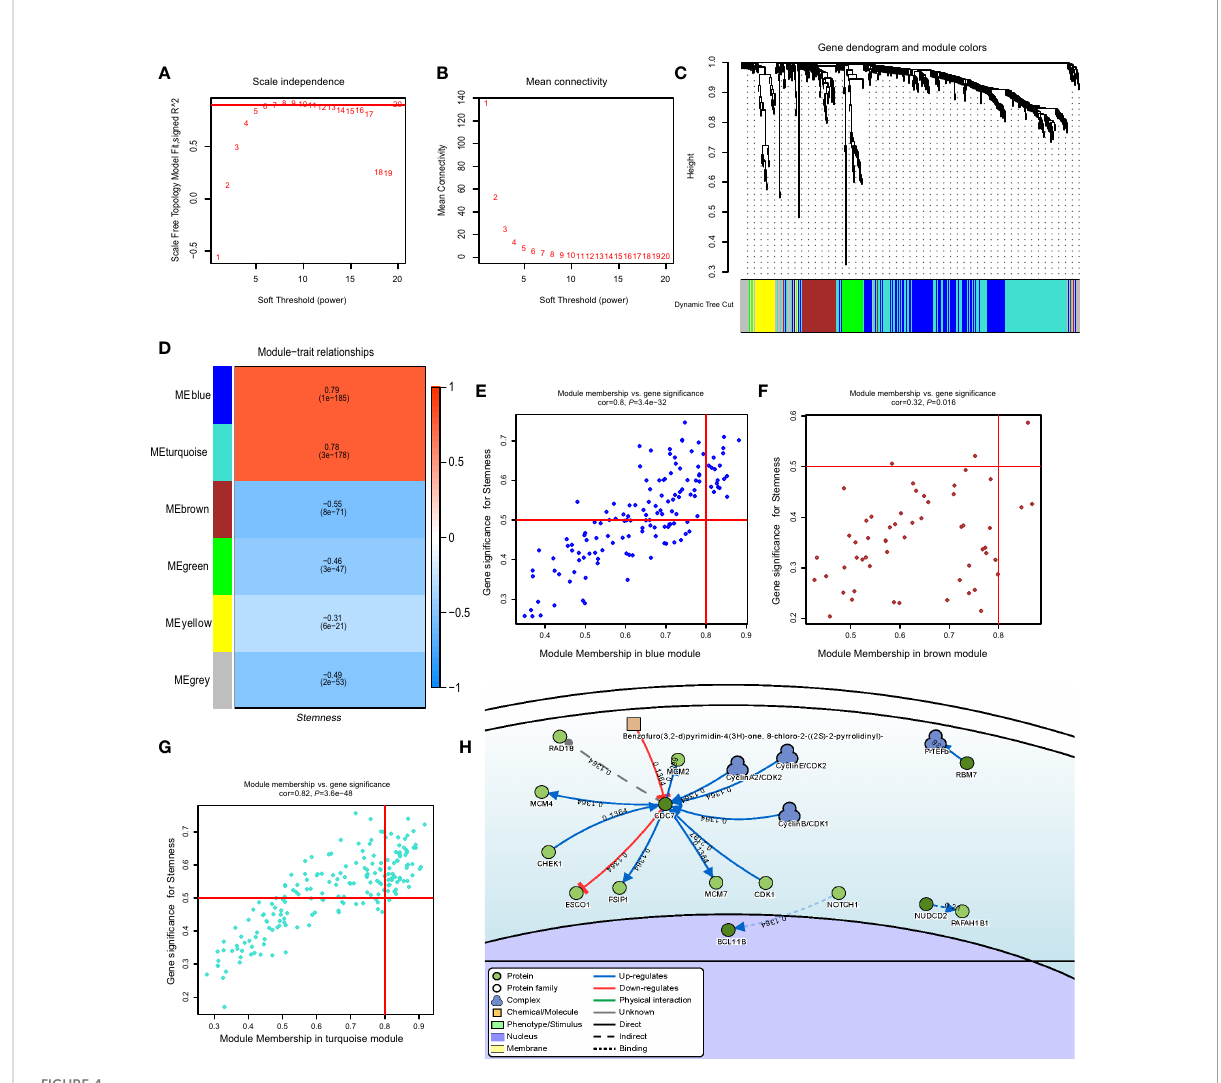
FIGURE 4 (A) Relationship of soft-threshold (power) with scale-free topology; (B) Relationship of soft-threshold (power) with mean connectivity; (C) WGCNA analysis of DEG. Different colors correspond to related modules; (D) Correlation coef fi cient between modules and the degree of stemness . P -values are listed in modules; (E – G) Scatter plot analysis of different modules in MEblue, MEbrown, and MEturquoise modules; (H) Gene-disease interaction network analyses of key genes in DisNor. WGCNA, Weighted Gene Co-expression Network Analysis; DEG, Differentially Expressed